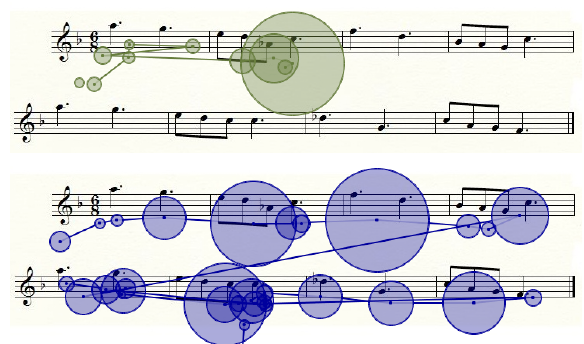
Figure 5. Example of visualization for one expert’s eye tracking scanpath (above) and one non-expert’s eye-tracking scanpaths (below) on the same musical excerpt and experimental conditions (simultaneous presentation and tone violation). Each color represents a different